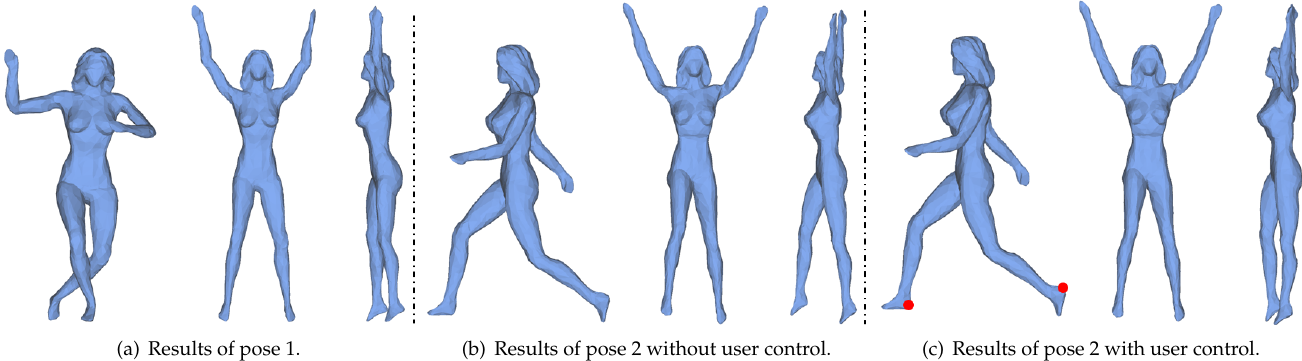
Figure 8. Different poses of the same model (( a )-left and ( b )-left) results in different canonical forms (( a )-right and ( b )-right). With user control (red point pair in ( c )-left), the quality of the canonical form can be largely improved (( c )-right). The second and third columns of each subfigure show the same model under two views.